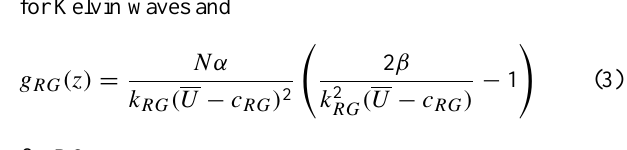
Fig. 3. Height profile of the zonal mean-flow acceleration in the stratosphere. Continuous line represents simulated profile (simu- lated using equatorial wave momentum fluxes near the tropopause level over Gadanki) and filled circles represent the observed pro- file (from balloon data over Trivandrum). Horizontal bars show r.m.s. variation of the observed zonal wind acceleration, (a) au- tumnal equinox (b) vernal equinox.